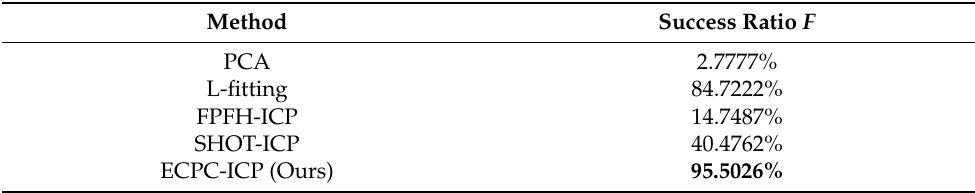
Table 2. Pose estimation success ratio F of different methods in all cases.